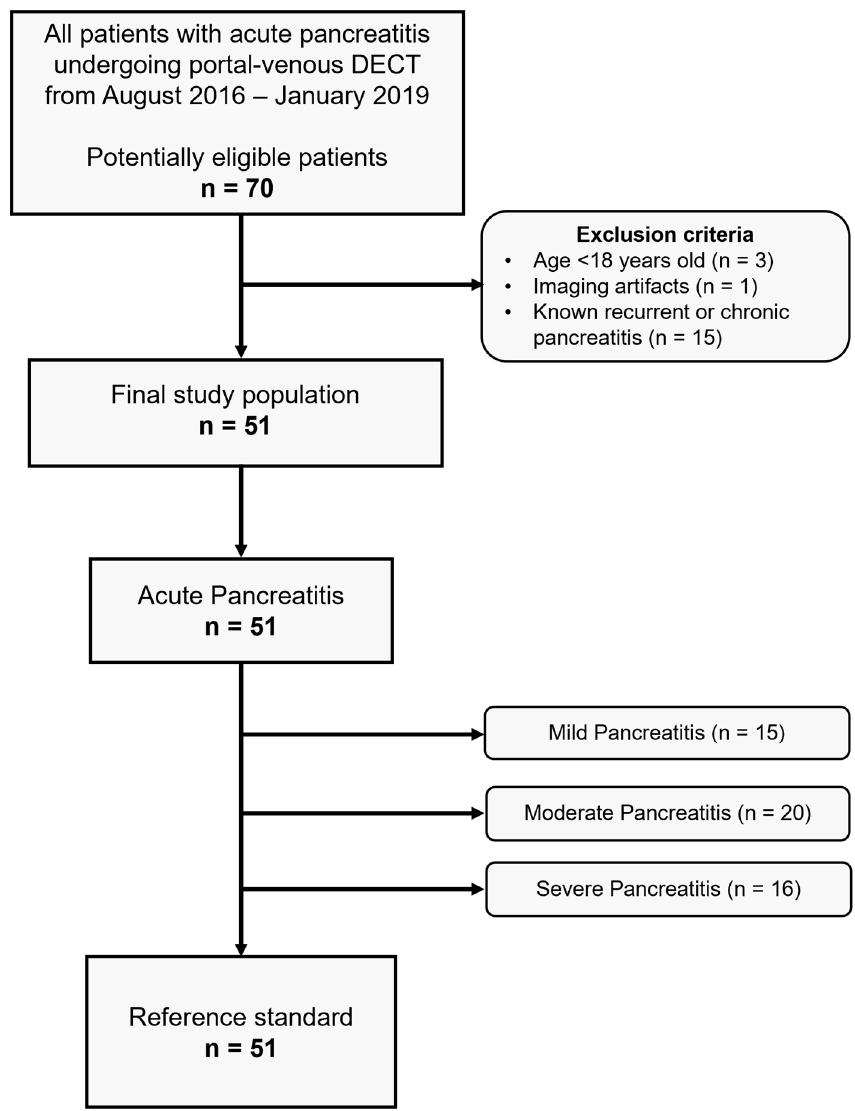
Figure 1. STARD flowchart of study inclusion.